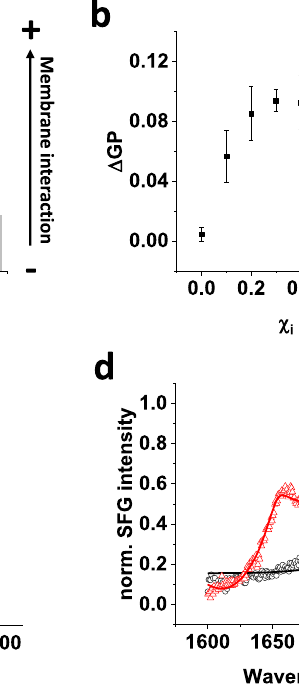
FTSA curve of Syn DLP HPRN-AAAA (Fig. 4e, red) indicated increased hydrophobic, ANS-accessible surface regions, visible as an increased starting F 470 nm value at 20°C. Most likely, surface regions, which are